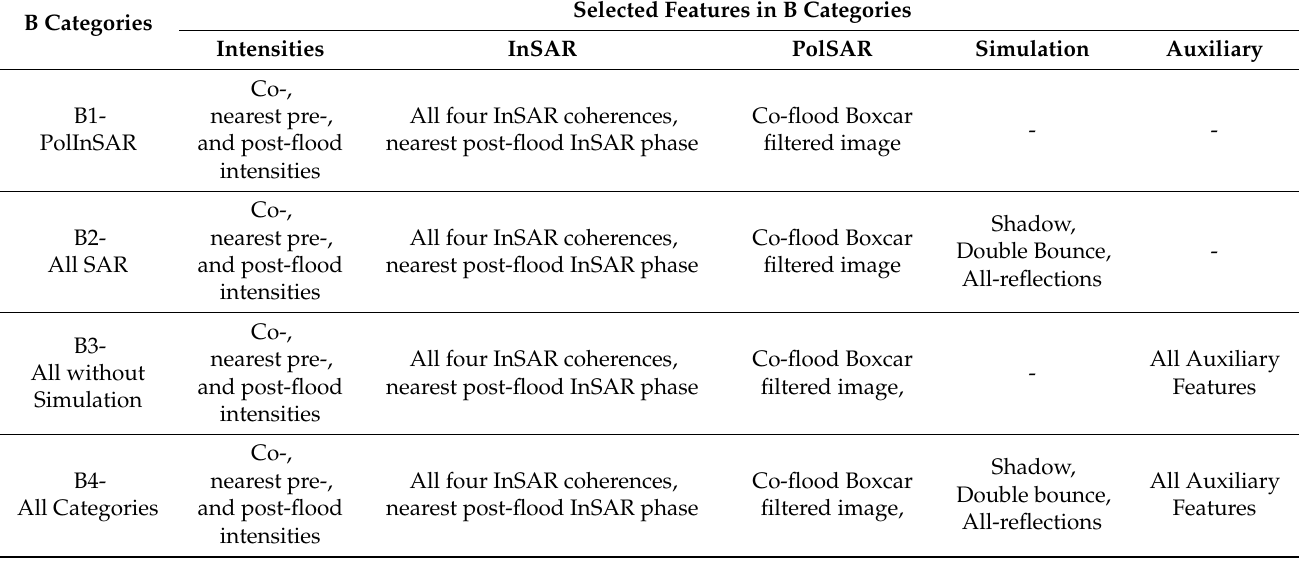
Table 7. Selected features in B